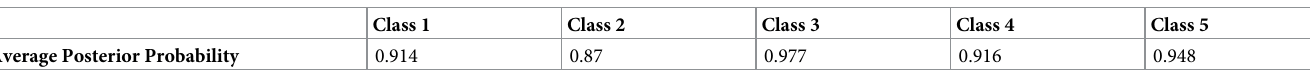
Table 3. Average posterior probability of the 5 latent class, logarithmic model specification.